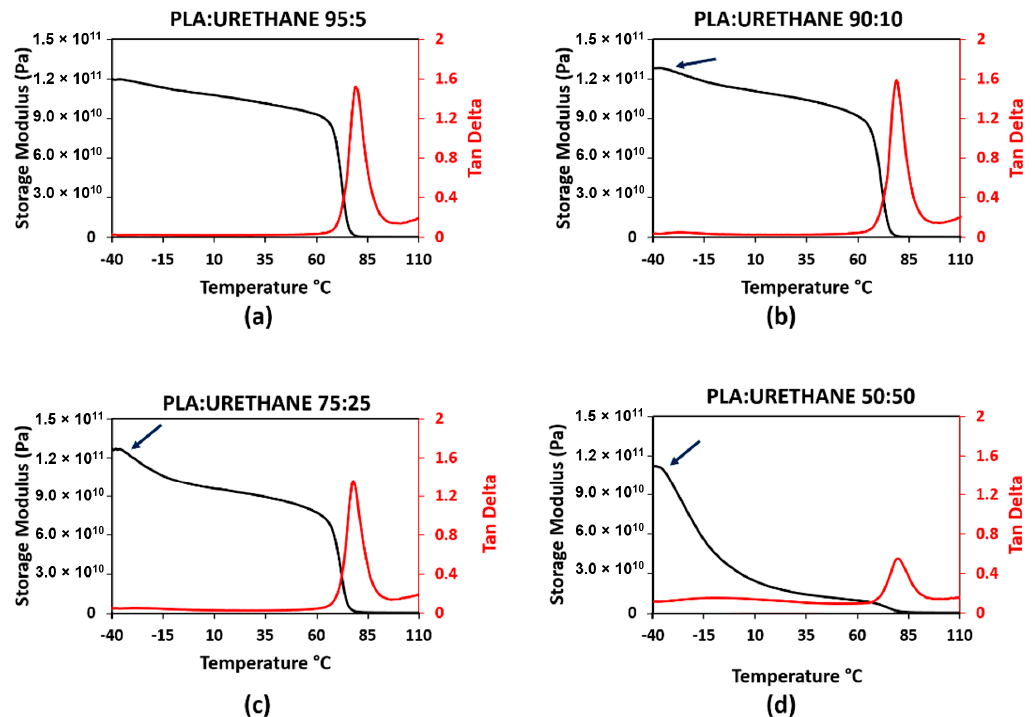
Figure 6. DMA curves for the PLA:TPU blend system where ( a – d ) correspond to 5, 10, 25, and 50% by weight TPU, respectively.